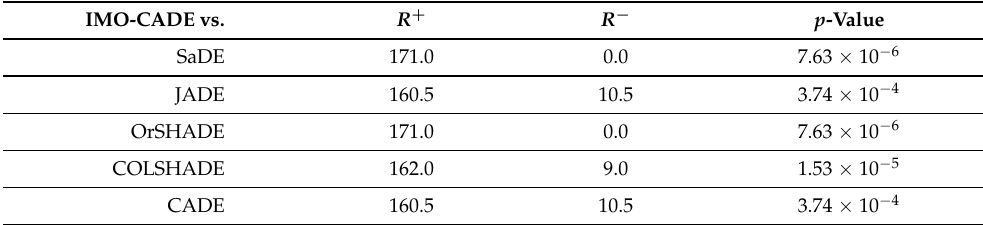
Table 2. Results obtained by the Wilcoxon test for IMO-CADE vs. other DEs under i.i.d. observations. Hereinafter, p ≤ 0.05 indicates that IMO-CADE significantly outperforms its competitors overall. IMO-CADE